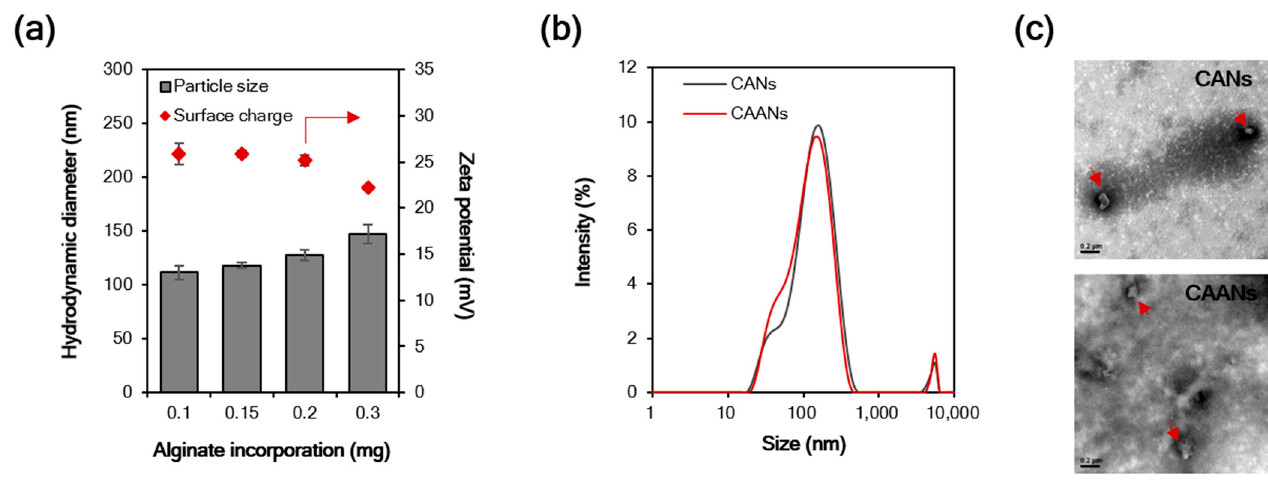
Figure 1. ( a ) Hydrodynamic diameter and surface charge of chitosan–alginate nanoparticles (CANs) with different alginate contents. ( b ) The size distribution of CANs and CAANs. ( c ) Transmission electron microscope images of CANs and CAANs (red arrow). Samples were negatively stained with 2% uranyl acetate before imaging. Scale bar = 200 nm.